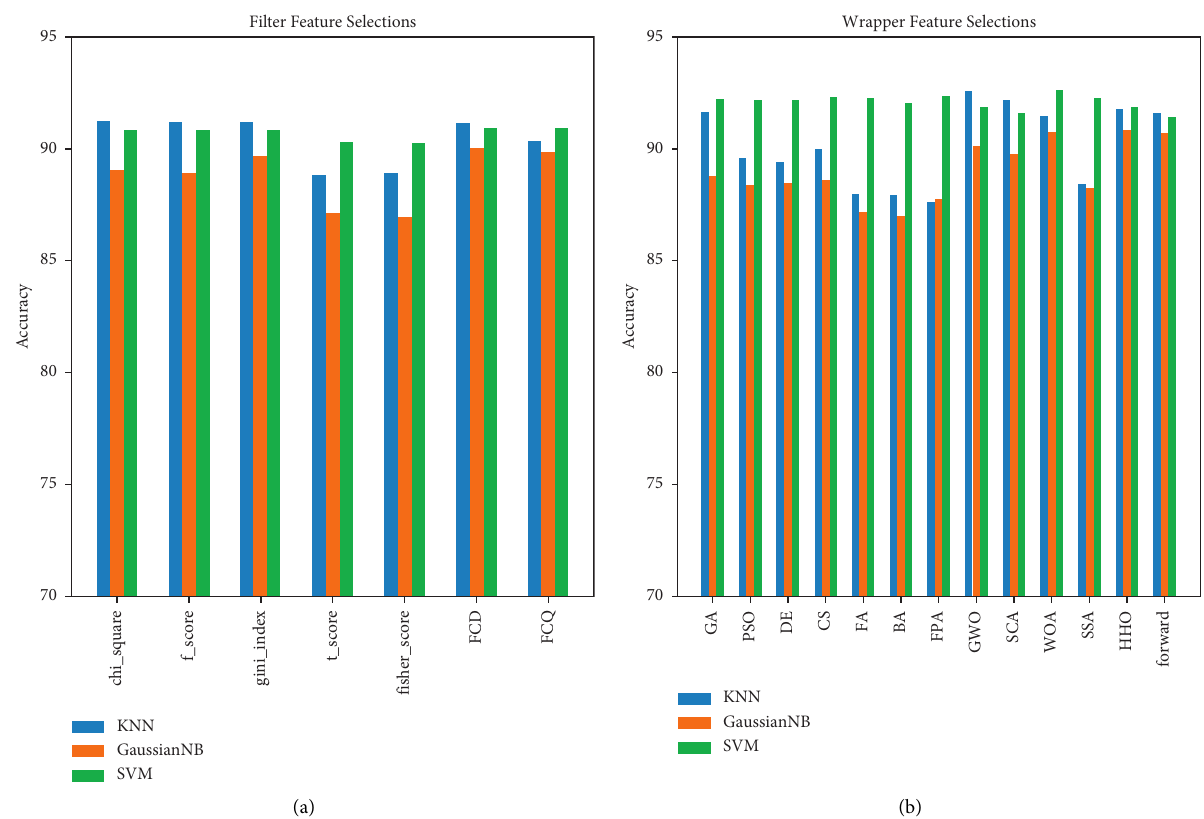
Figure 6: Accuracy of the 20 feature selection methods on the different classifiers. (a) Seven filter feature selection methods. (b) Thirteen wrapper feature selection methods.